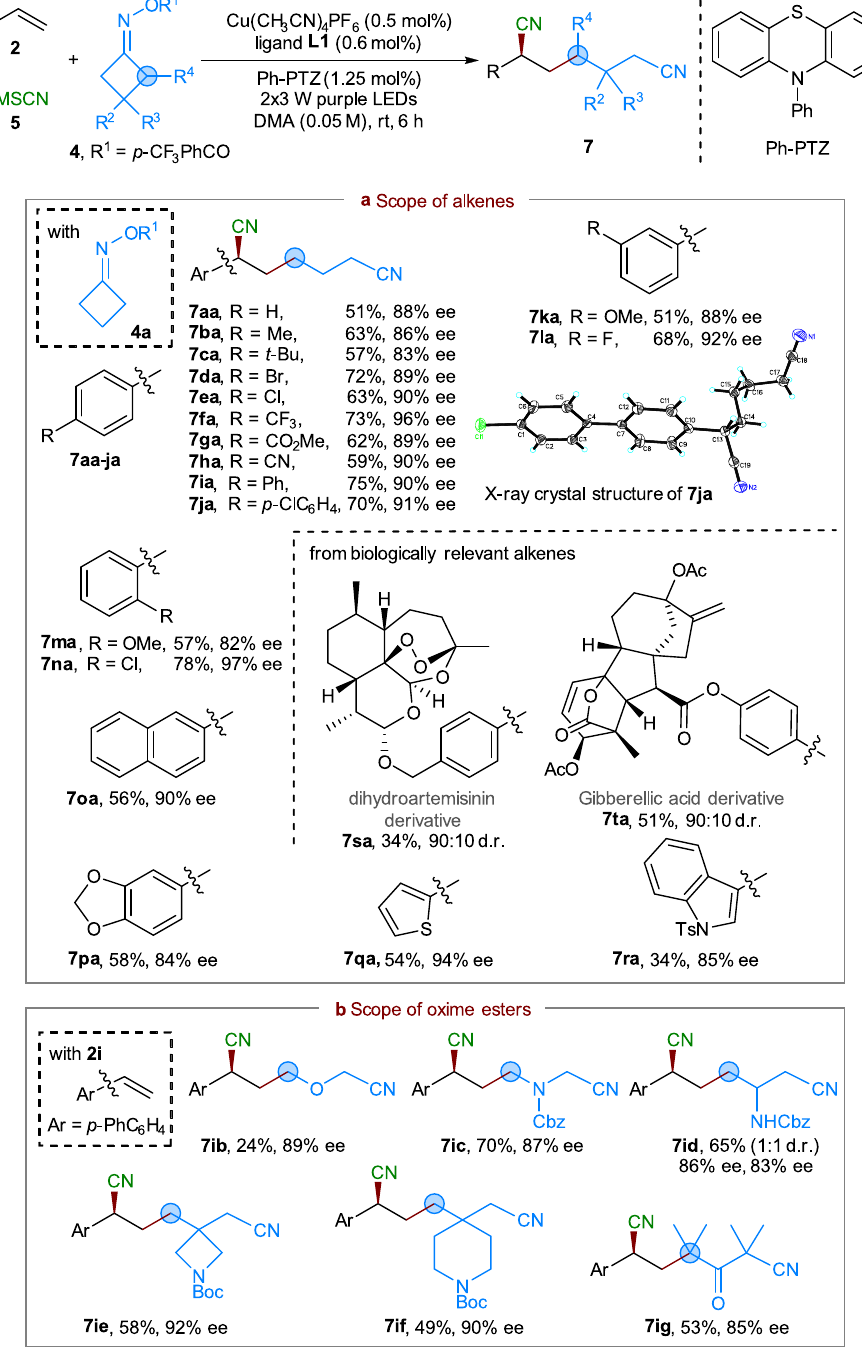
Fig. 5 Scope of the alkenes and cycloketone oxime esters in asymmetric three-component alkene cyanoalkylcyanation reaction. Reaction conditions: 2 (0.2 mmol), 4 (0.6 mmol), TMSCN (0.6 mmol), Cu(CH 3 CN) 4 PF 6 (0.5 mol%), ligand L1 (0.6 mol%), Ph-PTZ (1.25 mol%), DMA (4.0 mL), 2 × 3 W purple LEDs, at room temperature. Isolated yields were reported. The ee and d.r. values were determined by HPLC analysis on a chiral stationary phase. a Scope of alkenes. b Scope of oxime